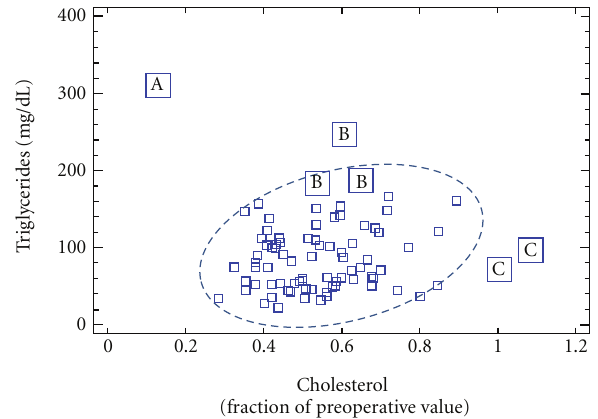
Figure 1: Patients on parenteral nutrition after LR. Within the main group of measurements (encircled), there is general reduction in plasma cholesterol compared to preoperative value, with low-normal triglycerides. A: measurement with the lowest cholesterol and highest triglyceride levels, without fat infusion, signalling the transition of a septic patient to preterminal illness and shock. B: measurements with less severe hypertriglyceridemia signalling transient but reversible worsening of septic illness in two patients undergoing fat infusion. C: measurements with increased cholesterol associated with development of cholestasis in another